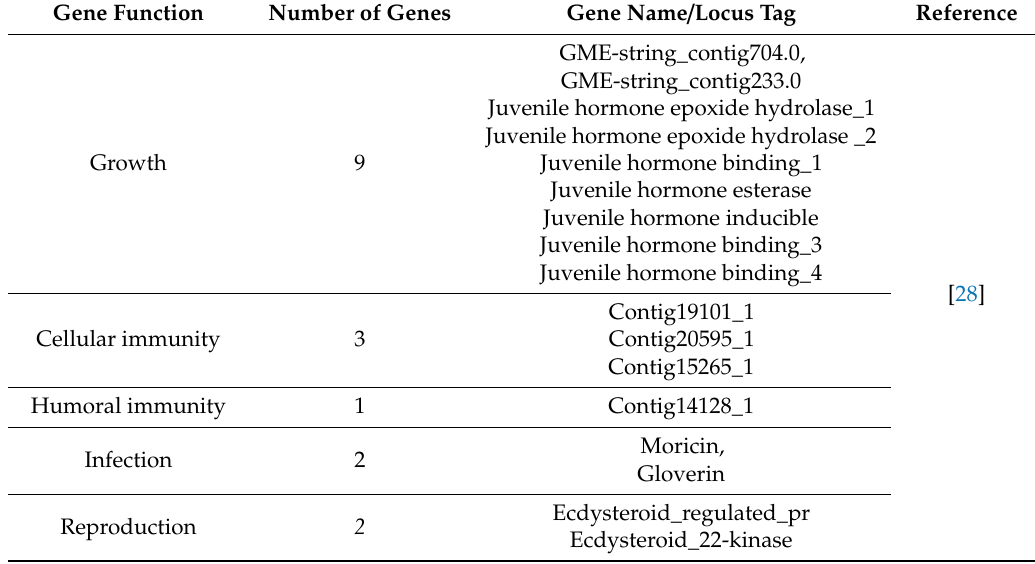
Table 2. Stress markers genes investigated during C. difficile infection and phage therapy regimens in G.